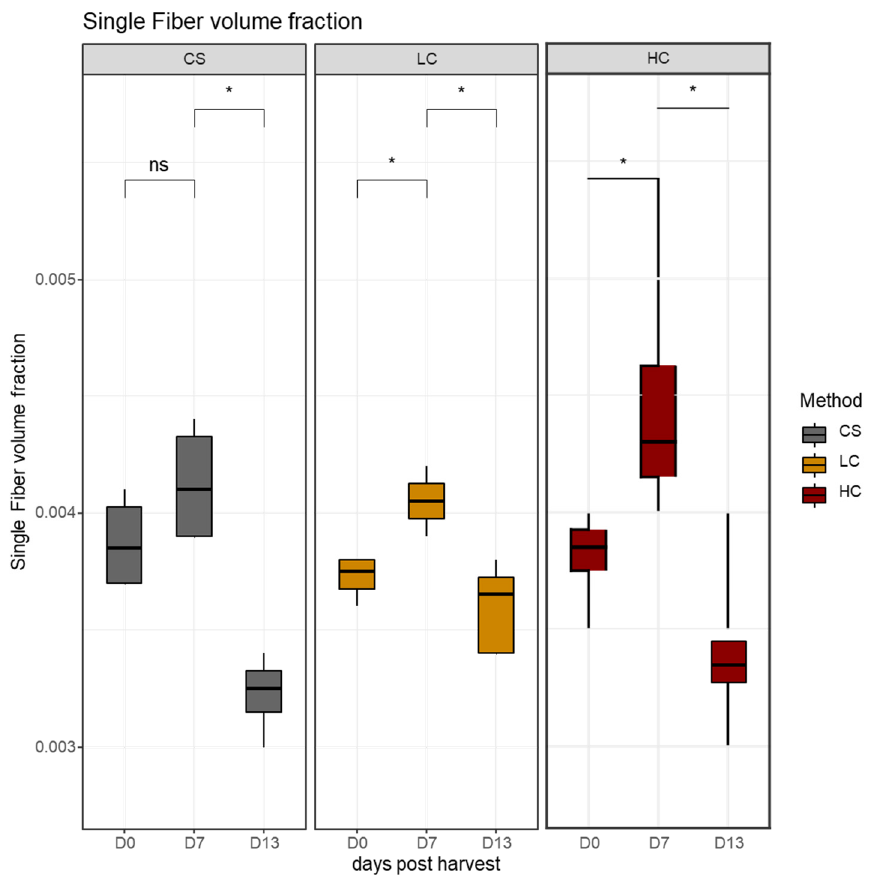
Figure 6. The volume density of single white muscle fibers in sampling days per harvest method. CS (gray): control group, LC (orange): low current group, HC (red): high current group. Superscripts indicate statistically significant differences between days in each harvest method (ns: p > 0.05, *: p < 0.05).